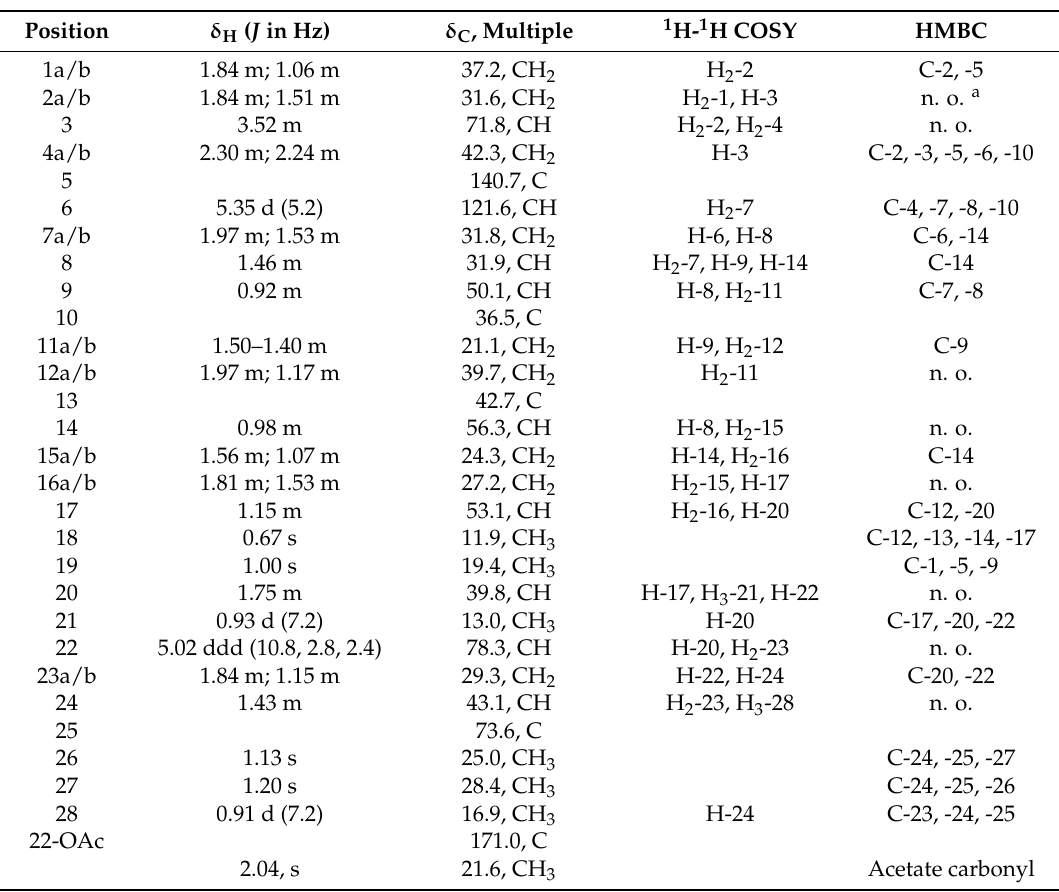
Table 2. 1 H (400 MHz, CDCl 3 ) and 13 C (100 MHz, CDCl 3 ) NMR data and 1 H- 1 H COSY and HMBC correlations for sterol 2 .